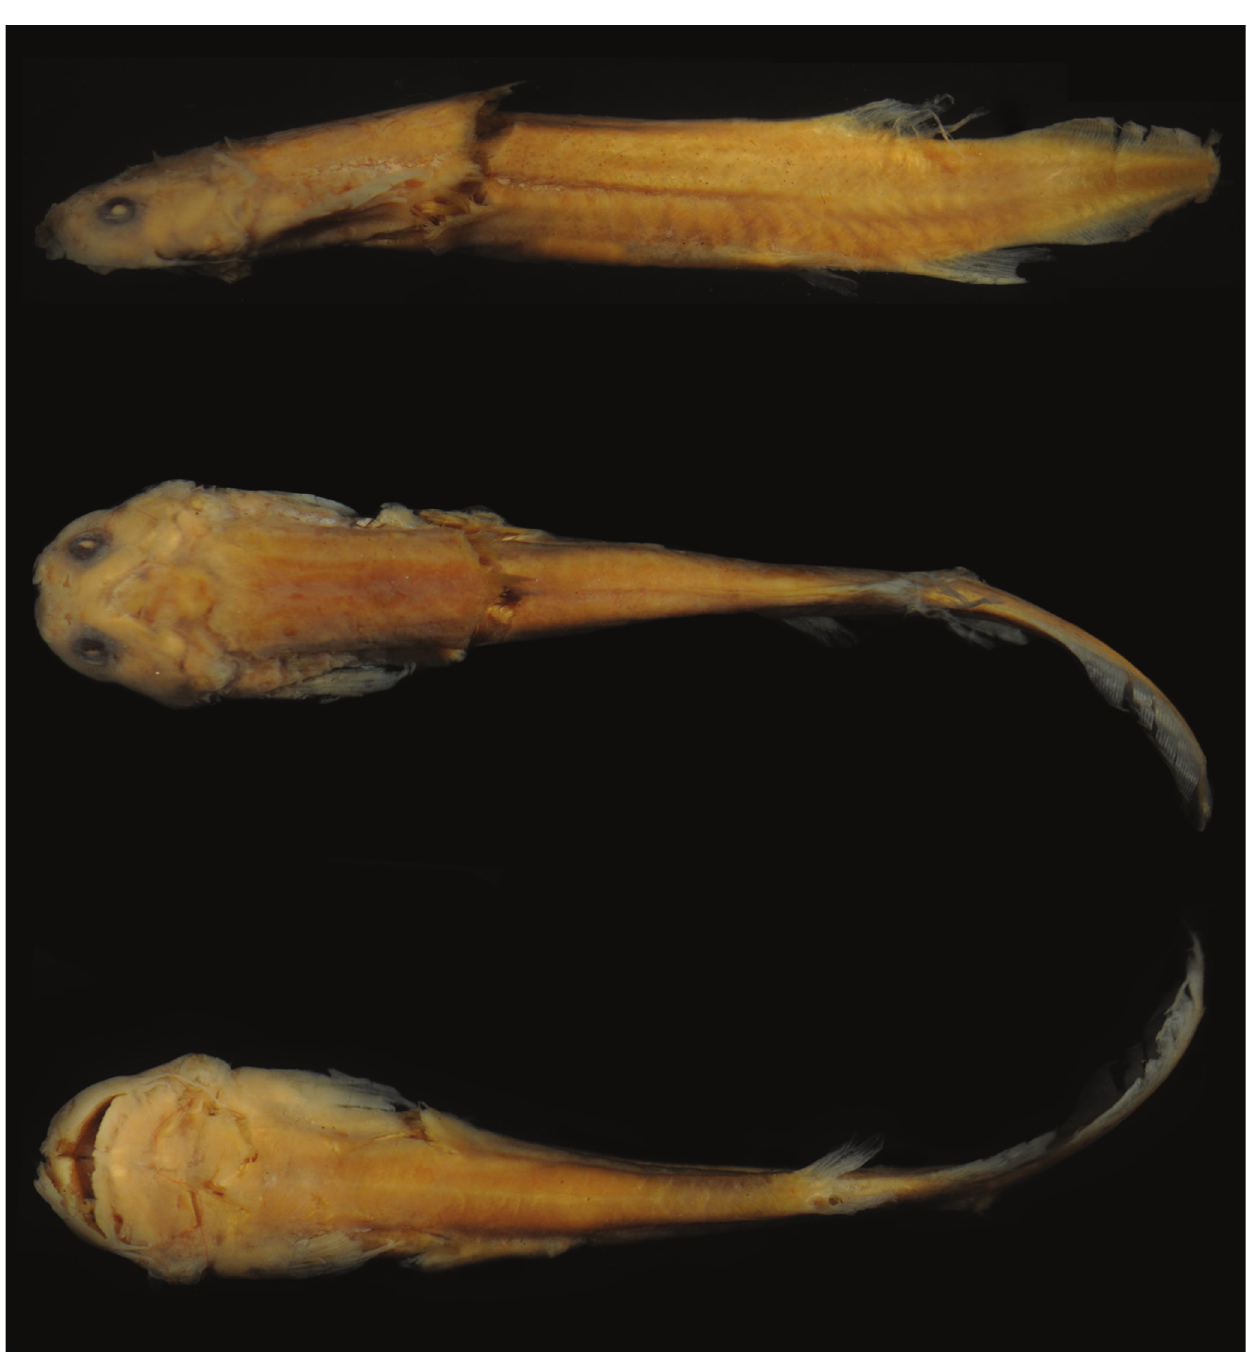
Fig. 1. Ochmacanthus batrachostoma , holotype, MNRJ 786 (29.15 mm SL), Brazil, Mato Grosso, Corumbá, rio Paraguai at São Luiz de